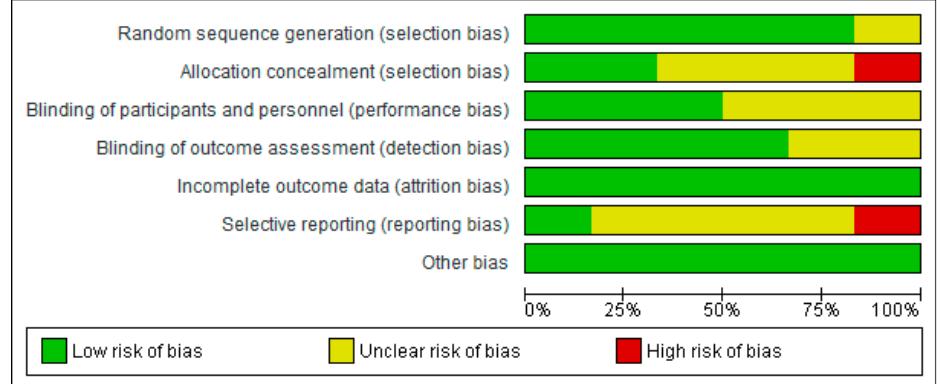
Figure 2. Risk of bias graph.